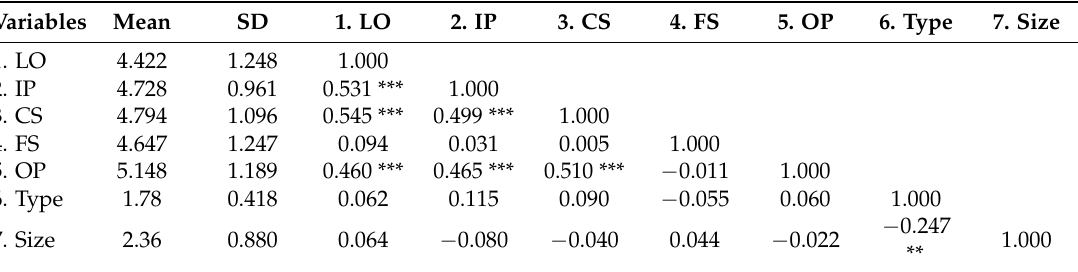
Table 3. Means, standard deviation and